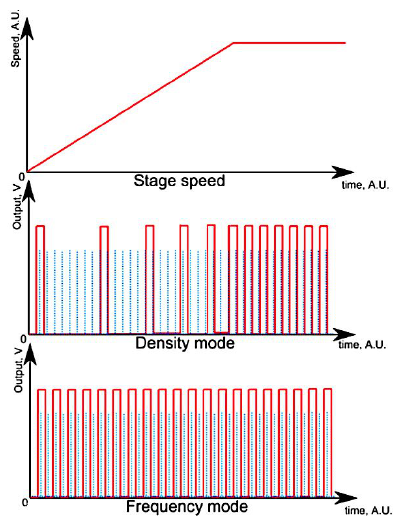
Figure 8. Density and Frequency Graph (A.U. stands for arbitrary unit)[5]